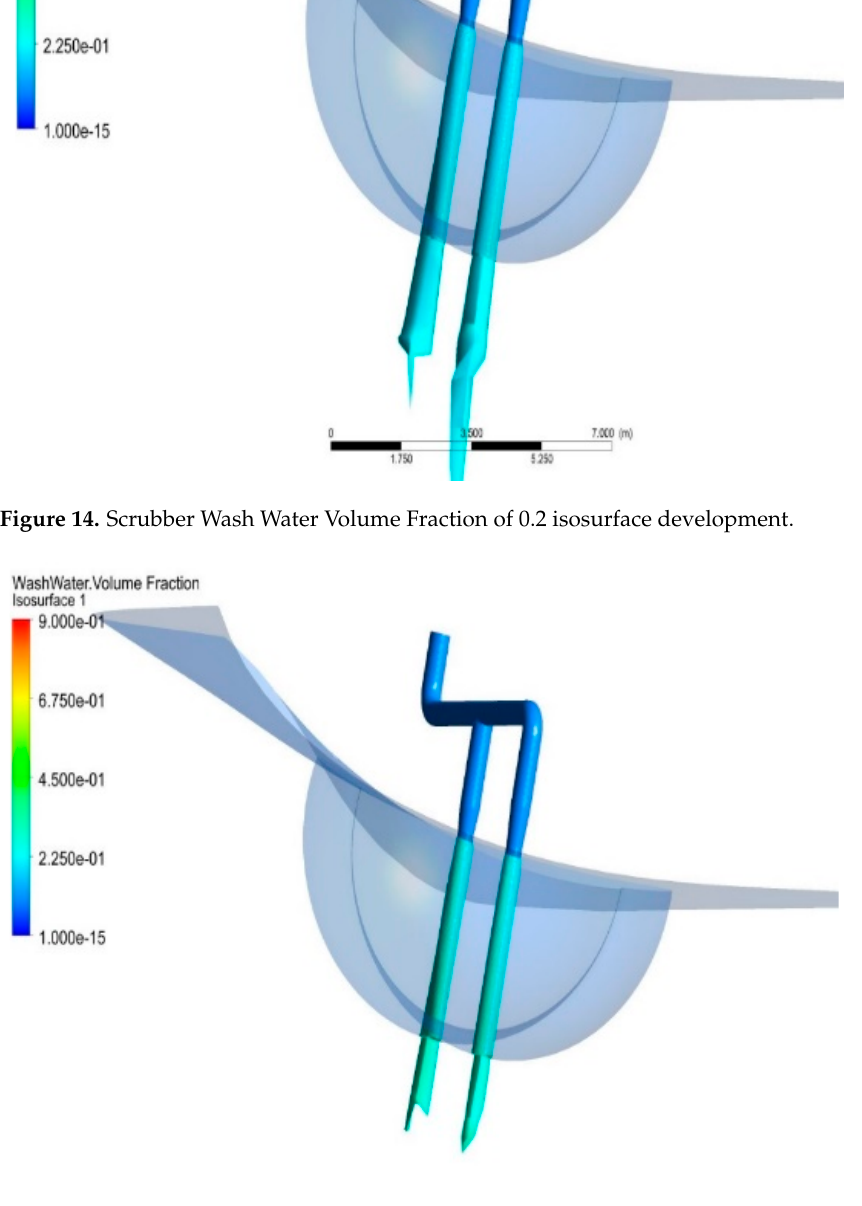
Figure 15. Scrubber Wash Water Volume Fraction of 0.3 isosurface development.